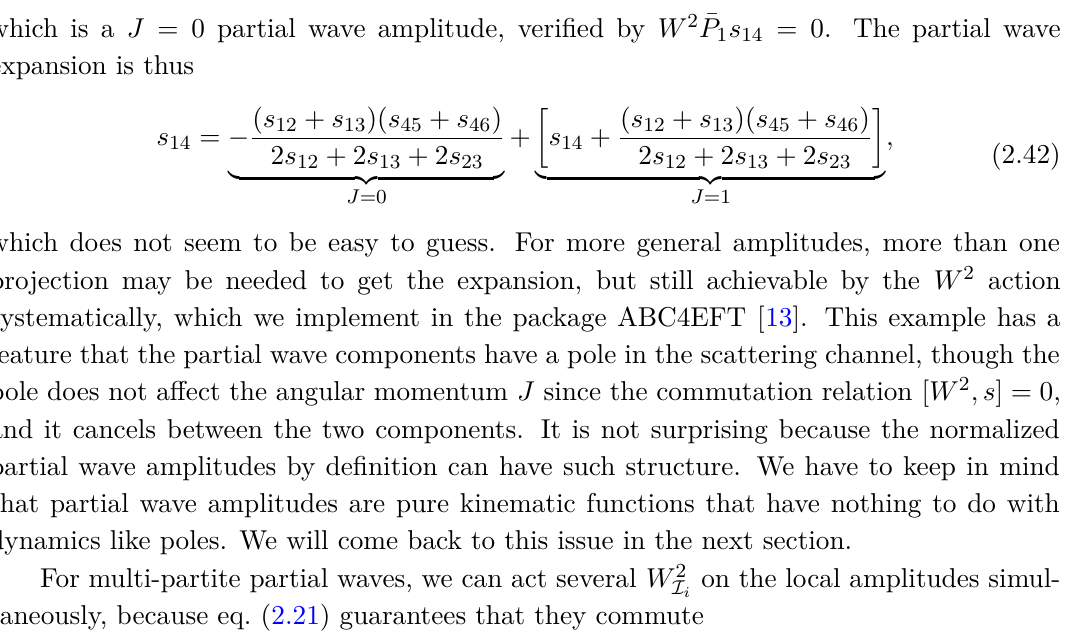
. The quantum numbers associated to them can be fixed 1 , I 2 } ] = 0 , W 2 I 1 I 2